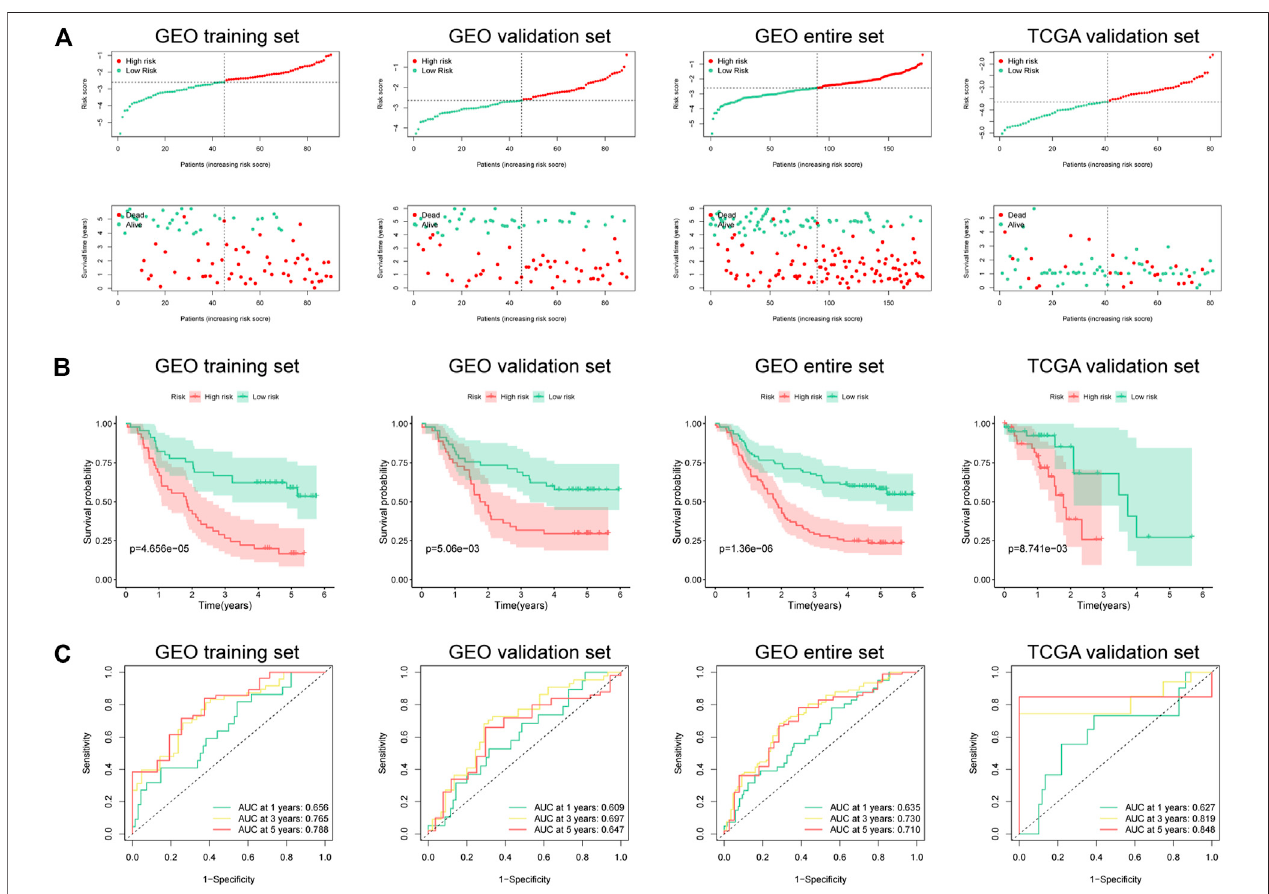
FIGURE 2 | Risk score of the prognostic signature that comprises seven FRGs for OS in four cohorts. (A) Risk score distribution and survival status of high- and low-risk patients. (B) Kaplan – Meier analysis on high- and low-risk patients. (C) Time-dependent ROC curve analyses on the GEO training set, GEO validation set, entire GEO set, and TCGA validation